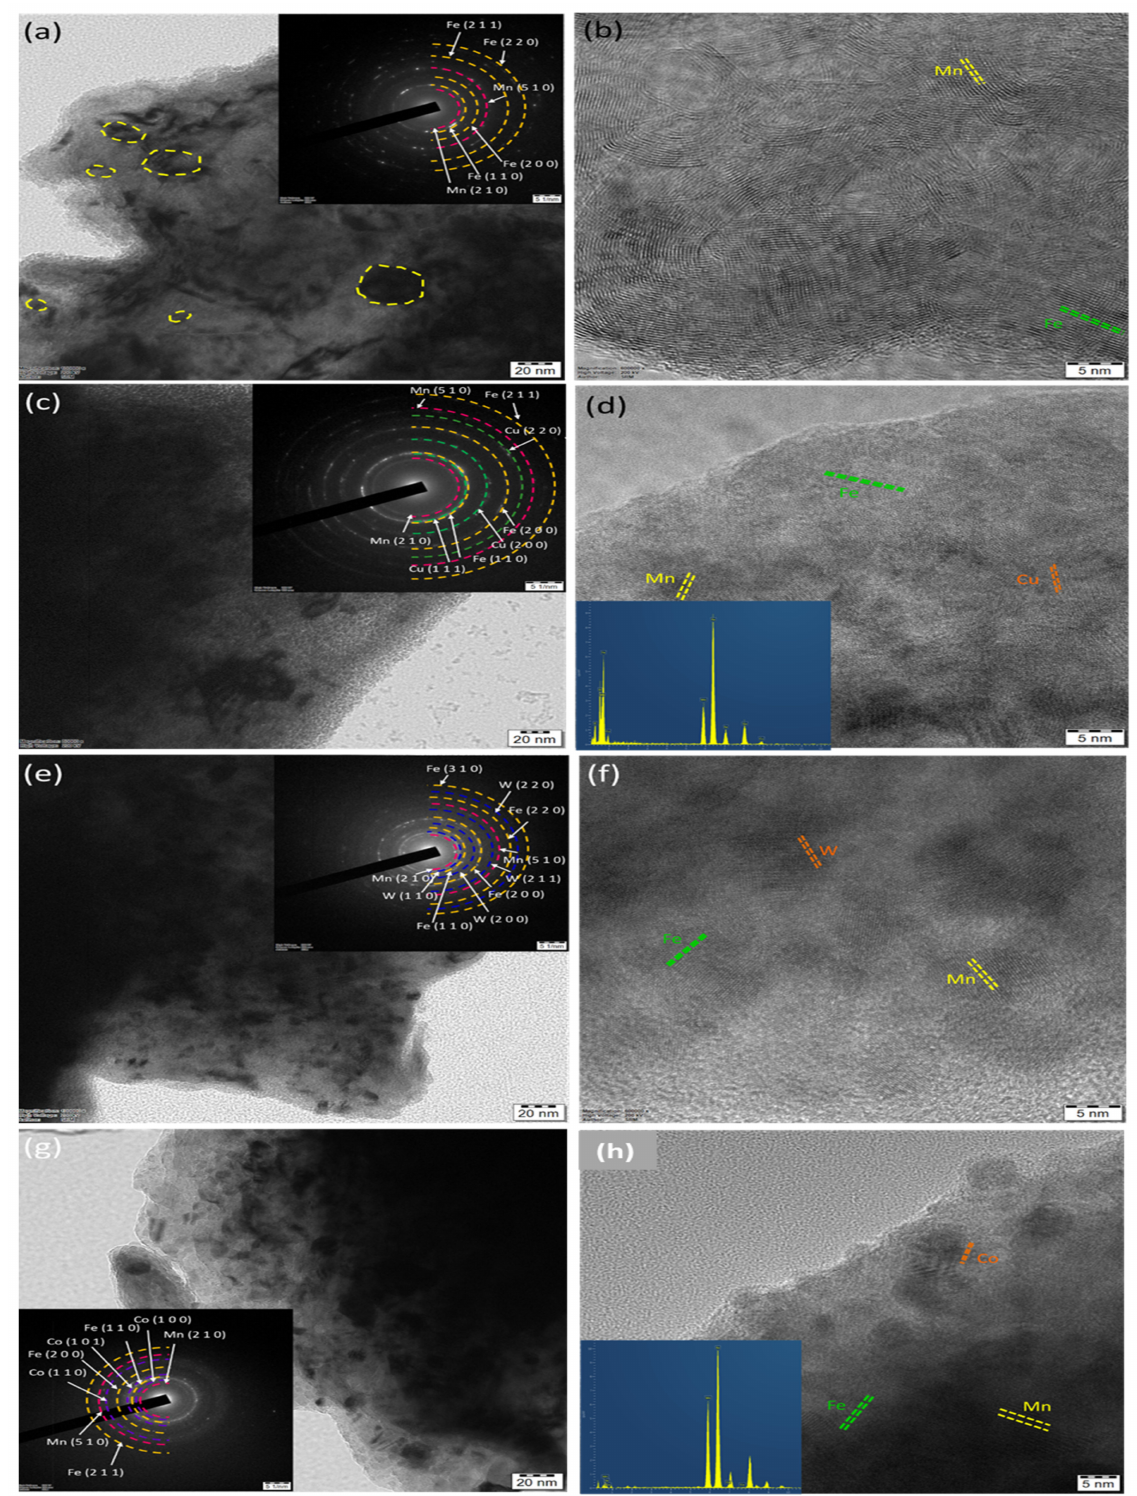
Figure 6. HRTEM analyses of MAed BM0, BM1, BM2, and BM3 nanocrystallite alloy powders: ( a ) bright filed image (BFI) of BM0; ( b ) lattice fringe image (LFI) of BM0; ( c ) BFI of BM1; ( d ) LFI of BM1; € BFI of BM2; ( e ) LFI of BM2; ( f ) BFI of BM3; and ( g ) LFI of BM3. Inset of ( a , c , e , g ) showing the corresponding SAED patterns; inset of ( d , h ) showing the corresponding